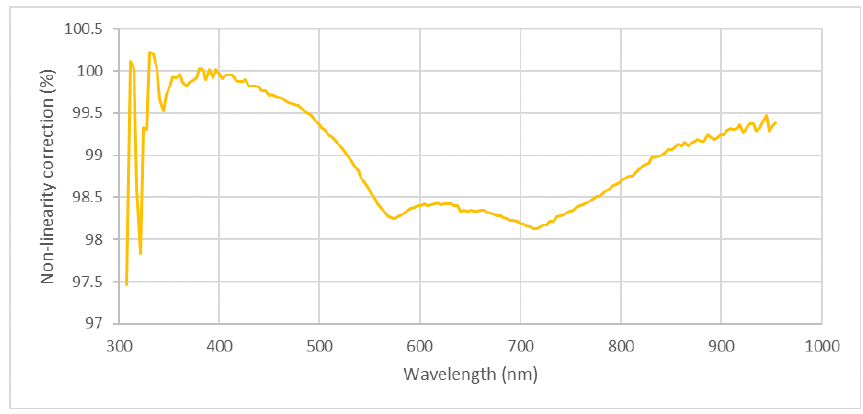
Figure 5. The non-linearity correction curve derived at the optical radiometry laboratory of Tartu Observatory.